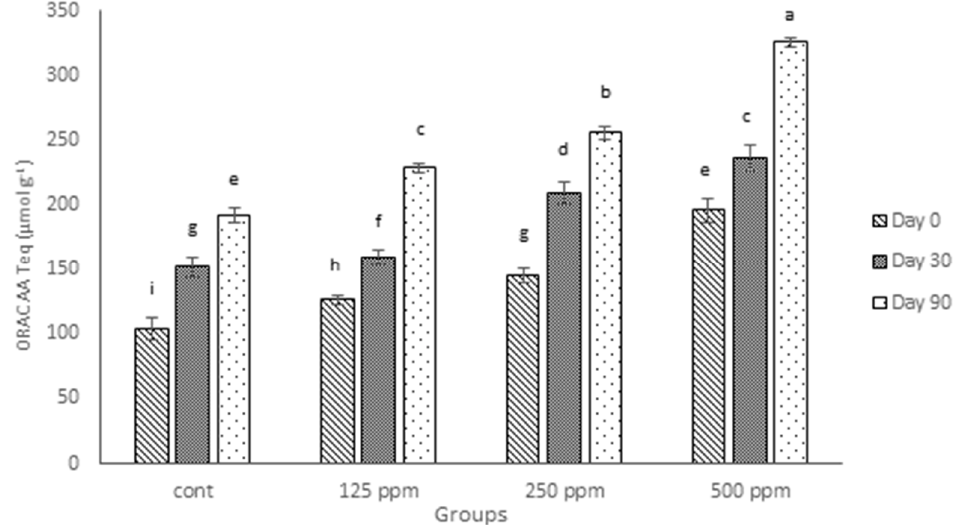
Figure 3. ORAC antioxidant activity of control cheese and cheeses containing different concentrations of free (+)-catechin during 90 days of ripening, expressed as Trolox equivalents per gram (Teq, µmol·g − 1 ) of fresh weight. Cont: control. Columns with different superscript letters differ significantly at p ≤ 0.05.